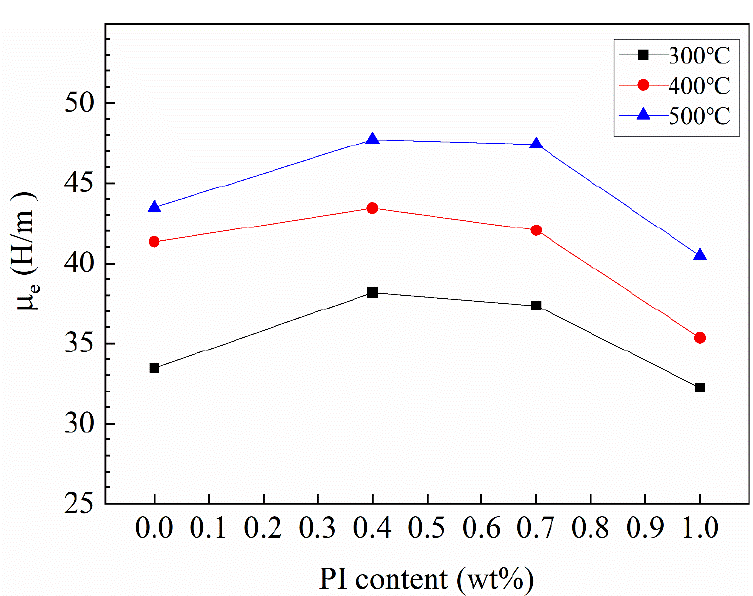
Figure 13. Trend of PI content and annealing temperature on effective permeability of Fe-Si-Cr SMCs. In the field of electromagnetism, the total core loss ( P cv ) consists of hysteresis loss ( P h ), eddy current loss ( P e ), and residual loss ( P c ); the residual loss is the micro-eddy current generated by the domain wall, which is very small compared with the hysteresis loss and eddy current loss and can be ignored. Additionally, the total core loss P cv can be expressed as Equation (2)